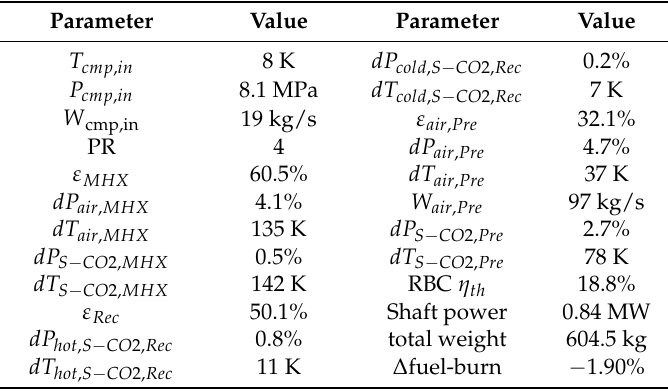
Table 10. Final RBC specifications at